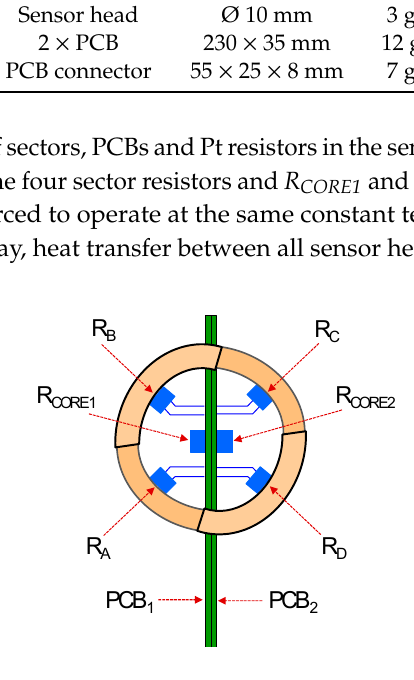
Figure 4. Detail of the two PCB, four-sector and two-core structure of the spherical head.